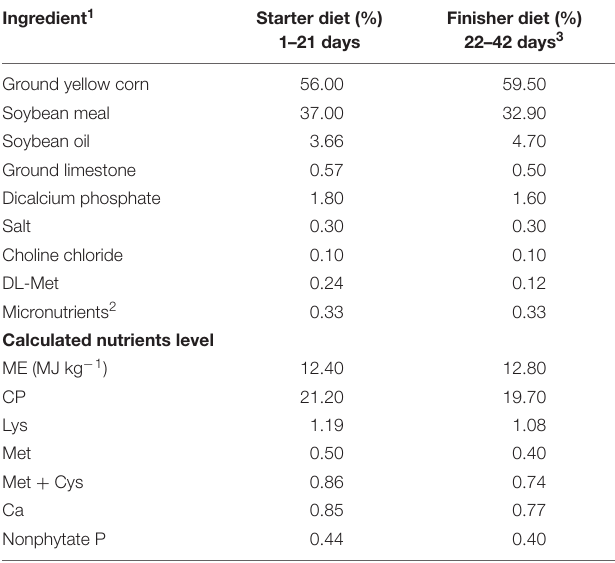
TABLE 1 | Composition of basal diets for broiler